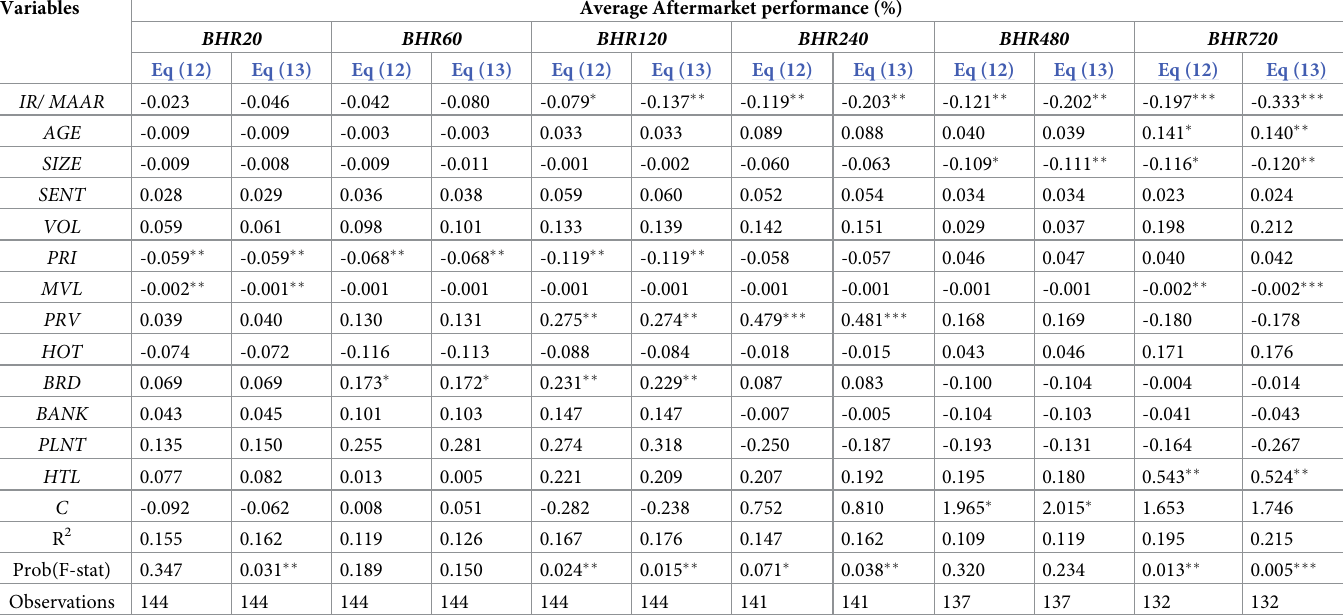
Table 9. Multiple regression analysis.